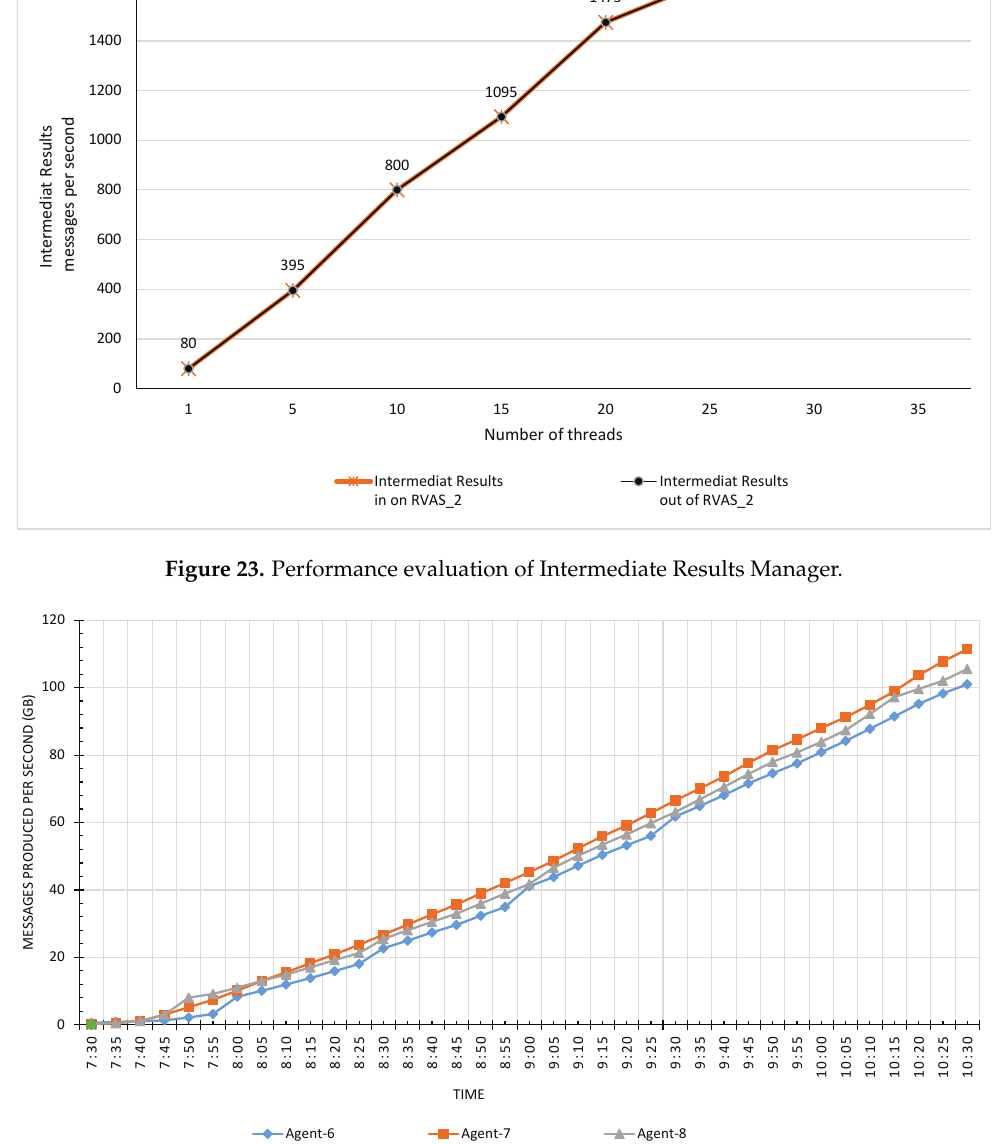
Figure 24. Total data consumed by the Broker